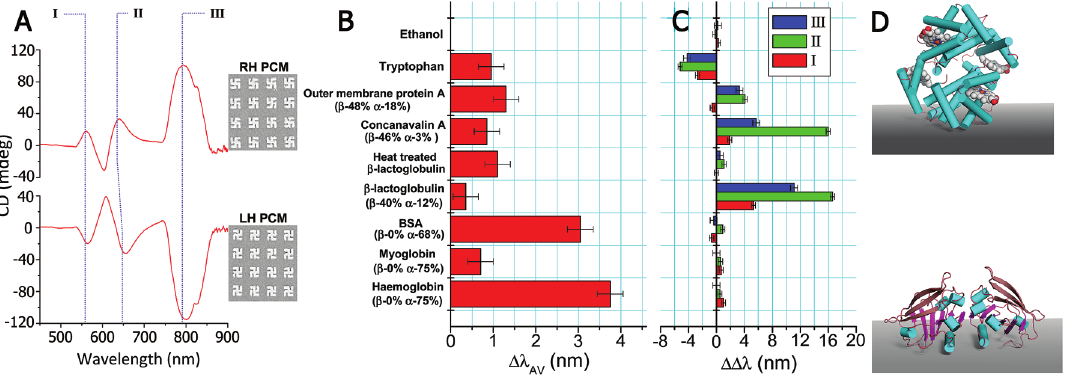
Figure 14 Superchiral field-based biosensing. (A) CD spectra of RH/LH PCMs. The curves for RH and LH gammadions are mirror images of each other due to their opposite chirality. (B) Average resonance shifts and (C) difference of resonance shifts between RH and LH PCMs on adsorption of chiral biomolecular layers. (D) Hemoglobin (top) and β -lactoglobulin (bottom) molecules adopt different geometries upon adsorption due to their different secondary structures ( α -helix, cyan cylinders; β -sheet, ribbons). Figures are adopted from Ref. [174] with